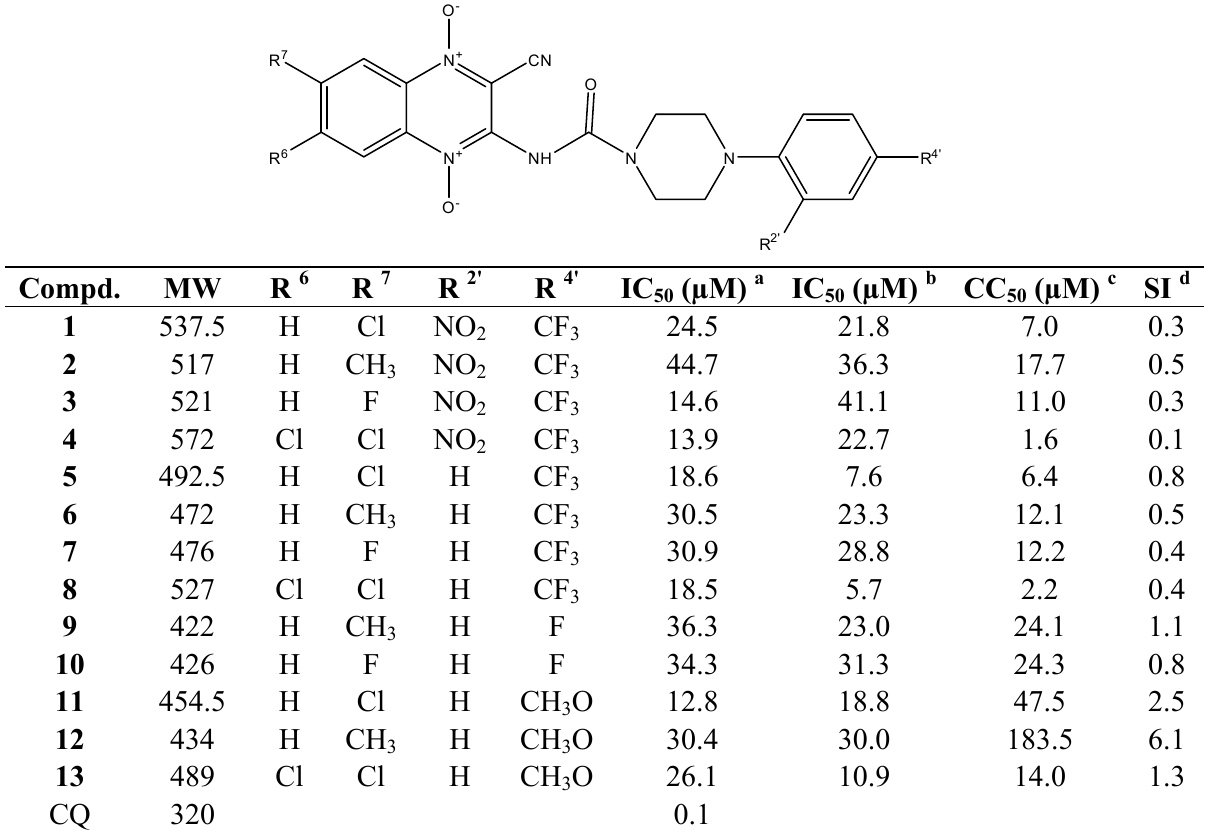
Table 1. Biological characterization of the thirteen new quinoxaline 1,4-di- N -oxides. R